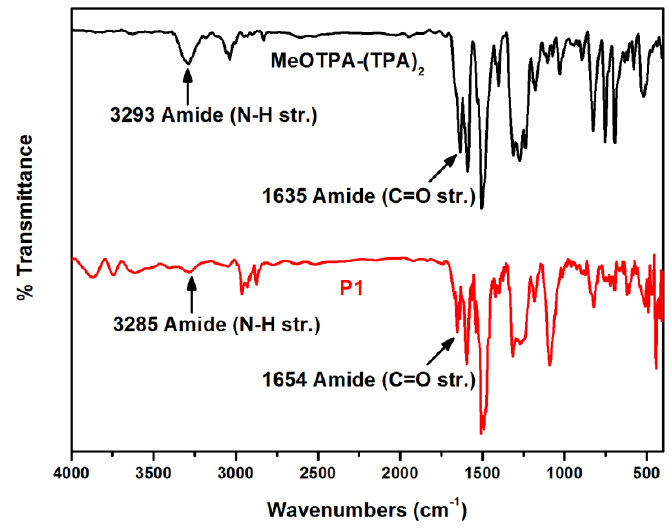
Figure 7. IR spectra of MeOTPA-(TPA) 2 and P1 film.